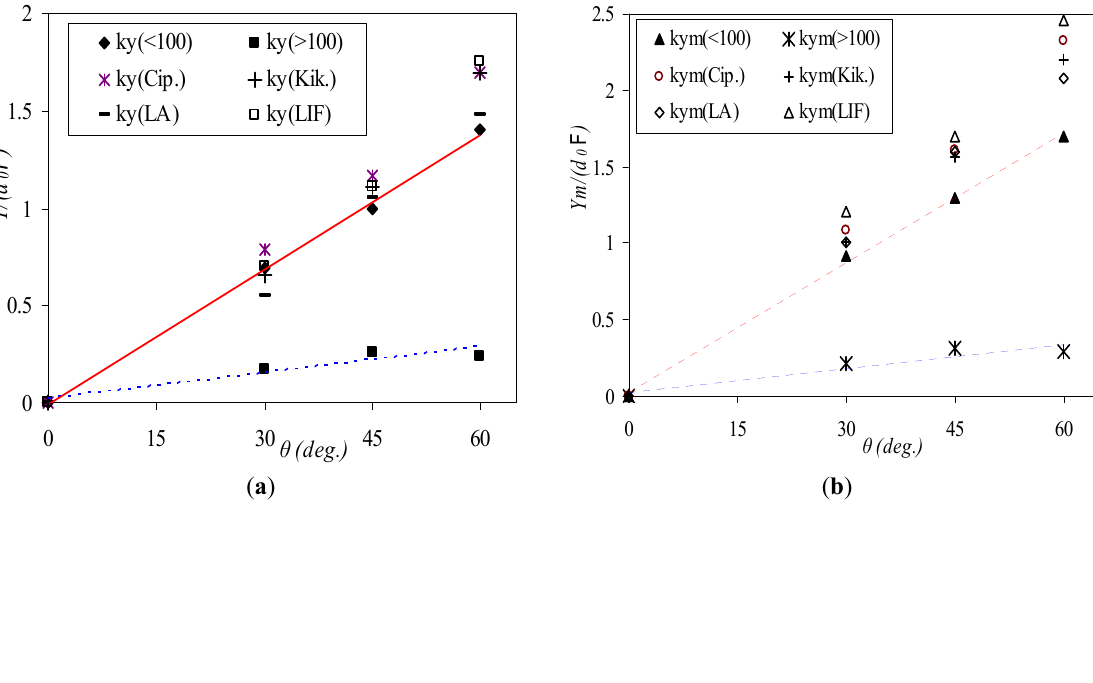
F ) ) as a function of initial jet angle for densimetric = Y /(d m m 0